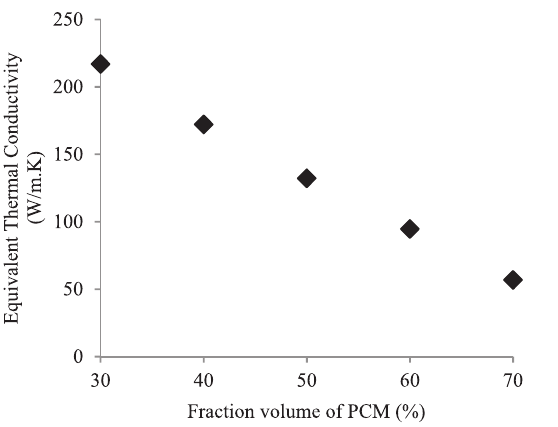
Fig. 7: Results studying the increase of the number